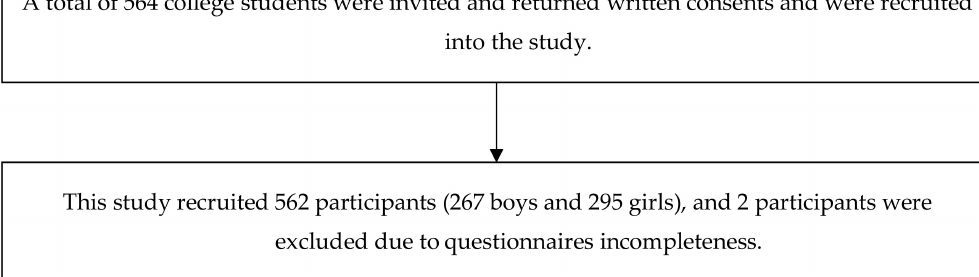
Figure 1. Flow chart of the selection of